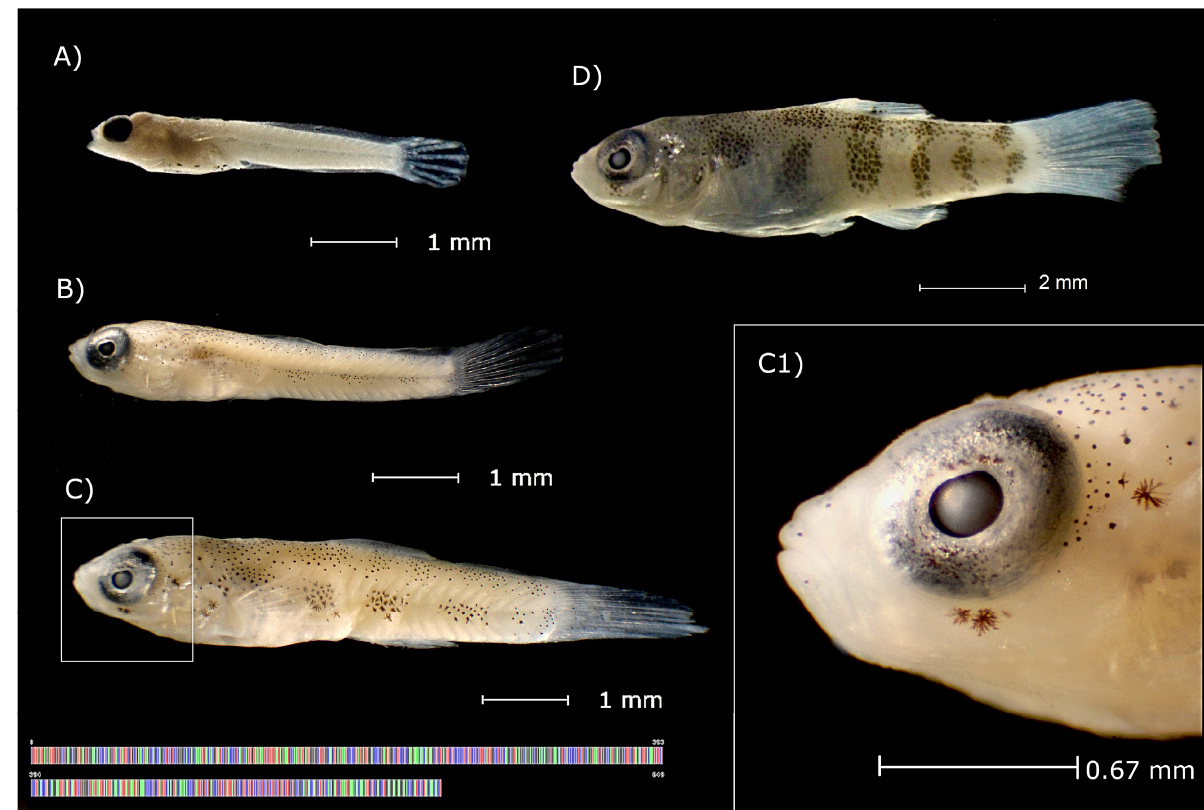
Figure 3. Early stages of development of Cyprinodon artifrons with their DNA barcode. ( A ) LT = 4.6 mm; ( B ) LT = 5.5mm; ( C ) LT = 6.9 mm; ( C1 ) Pigments below the eye and pupil shape. ( D ) LT = 11